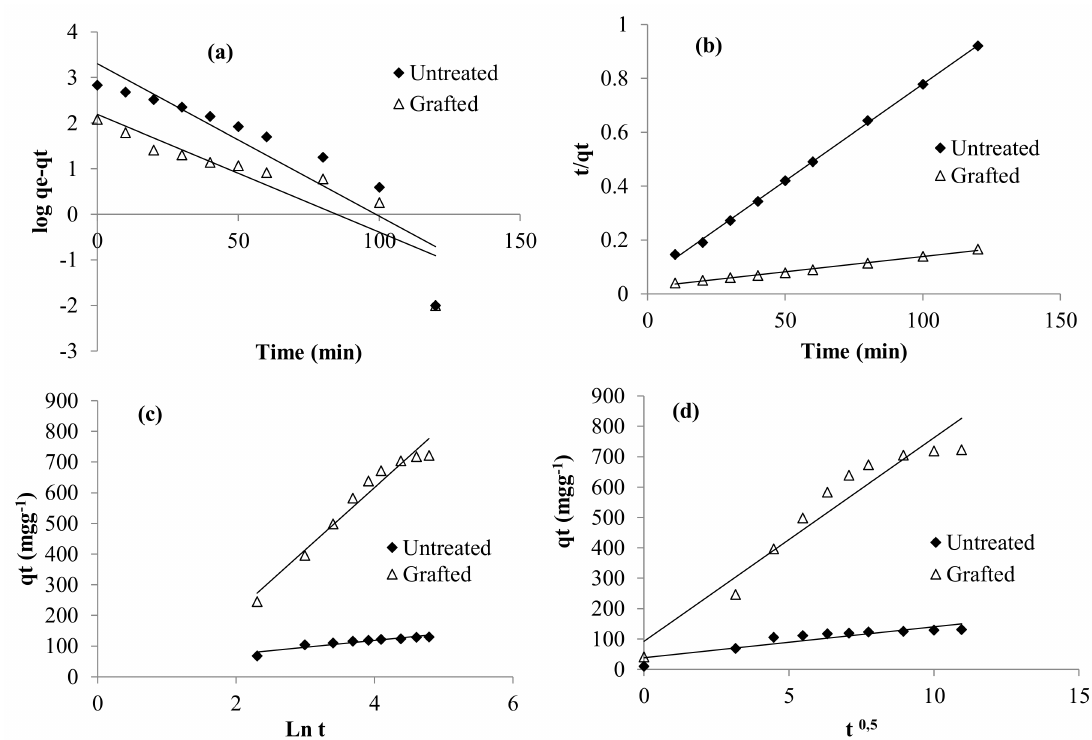
Figure 10. Pseudo First order ( a ), Pseudo second order ( b ), Elovich ( c ), Intra-particular Diffusion ( d ) models for the adsorption of RR198 onto the PEM bio-sorbent. Table 3. The kinetic data models of the adsorption of RR198 dye using PEM bio-sorbent.